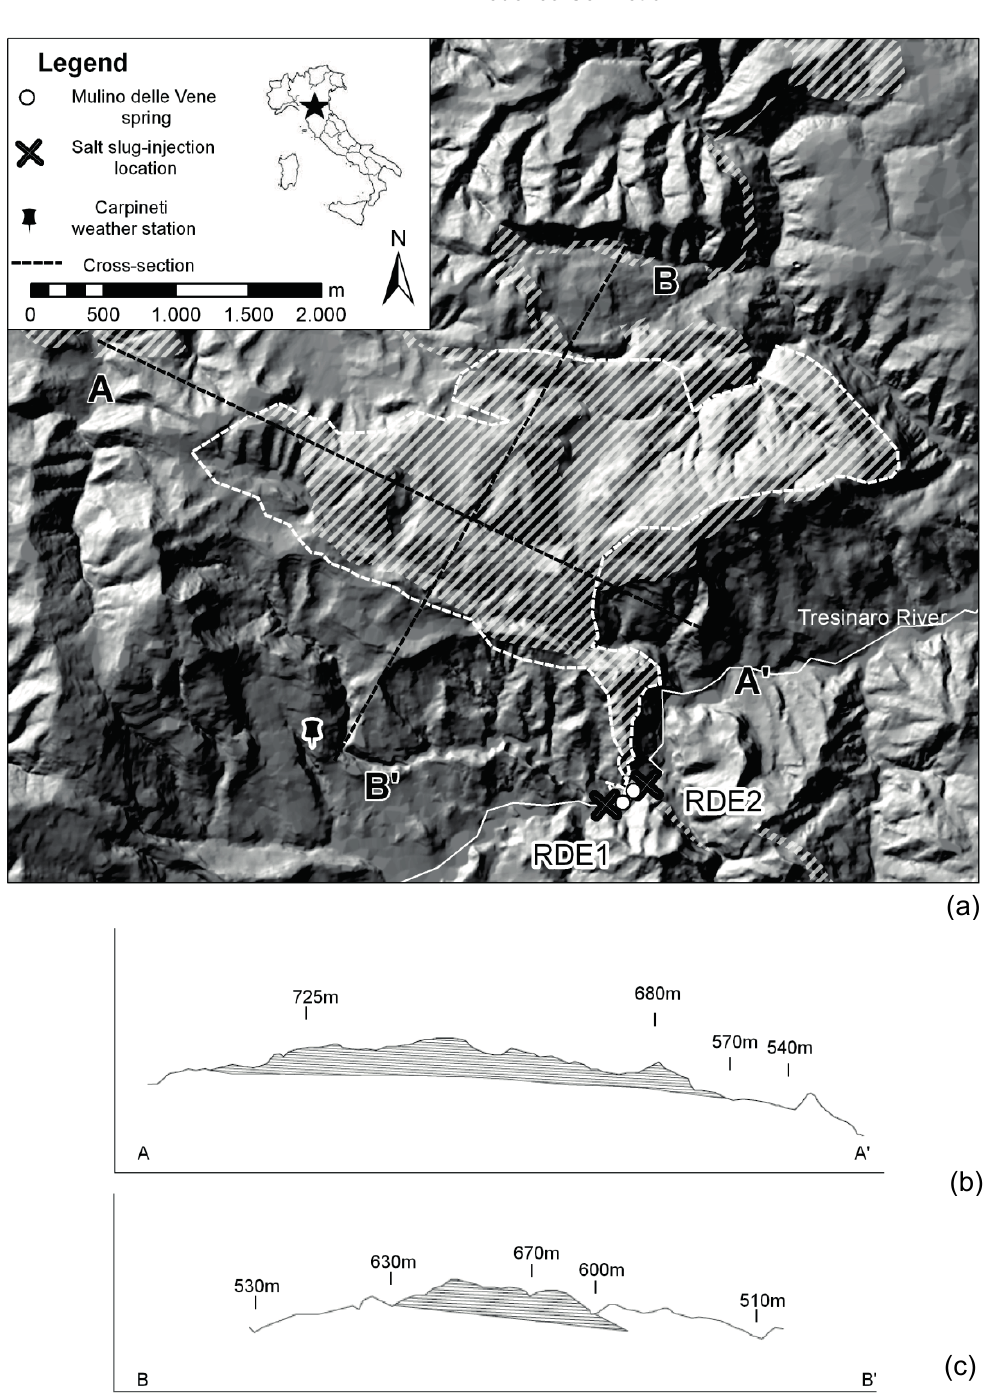
Fig. 1 Study area. (a) Mulino delle Vene springs area. The border of the arenite slab is identified by the white dashed line; the arenite unit outcrops also outside of the slab (white hatched lines area). (b), (c): simplified hydrogeological sections (not to scale). In grey arenitic units, in white marly